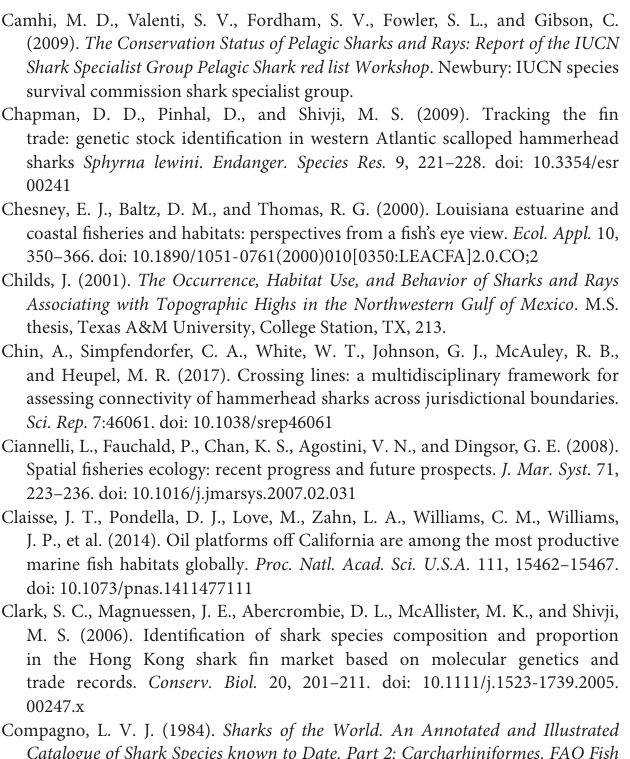
TABLE S1 | Environmental variables retained in the final generalized additive model (GAM) describing the presence/absence of tagged scalloped hammerheads. Model fit was assessed with Akaike’s information criterion (AIC)